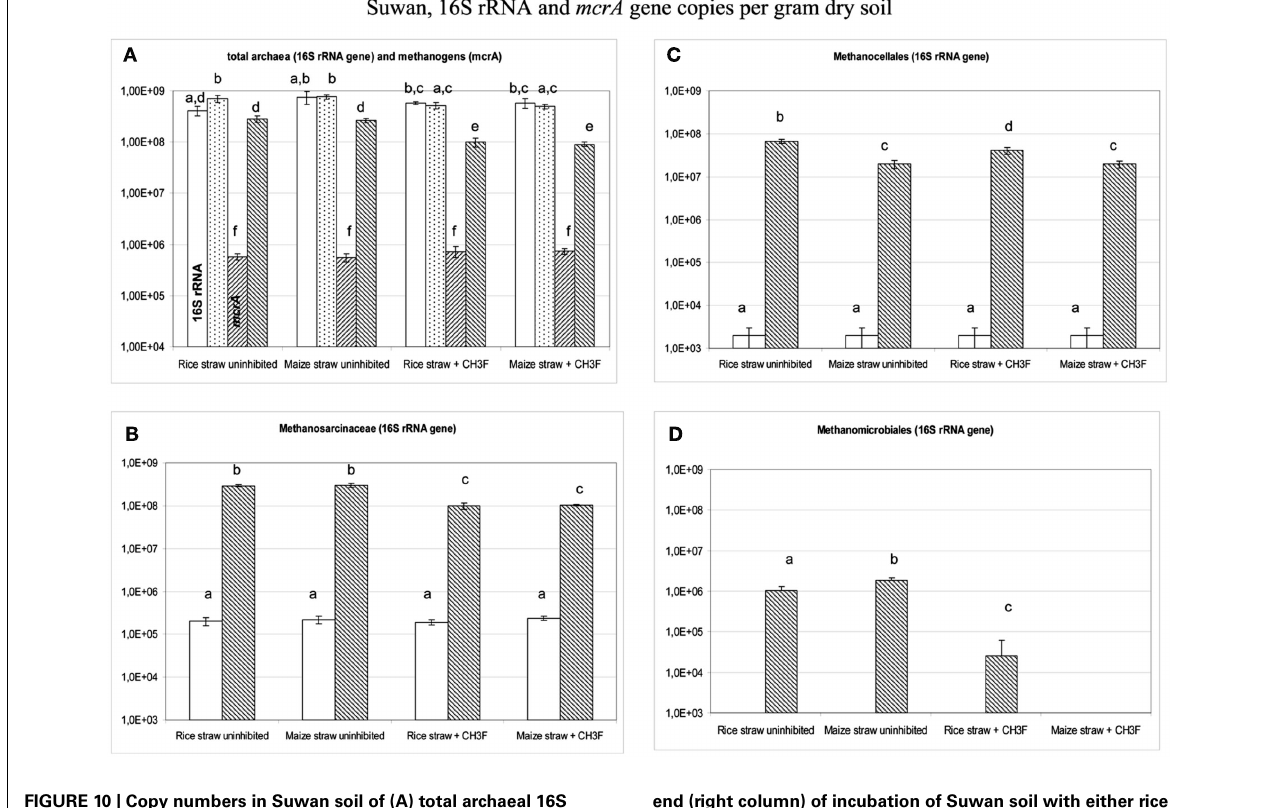
FIGURE 10 | Copy numbers in Suwan soil of (A) total archaeal 16S rRNA genes (the two left columns in each group) and total mcr A genes (the two right columns in each group), and of 16S rRNA genes belonging to (B) Methanosarcinceae, (C) Methanocellales, and (D) Methanomicrobiales at the beginning (left column) and the